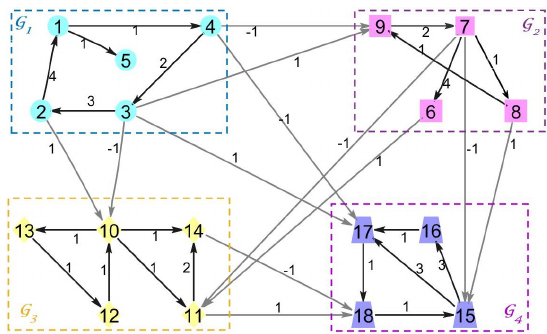
Figure 1. The acyclic partition topology for four